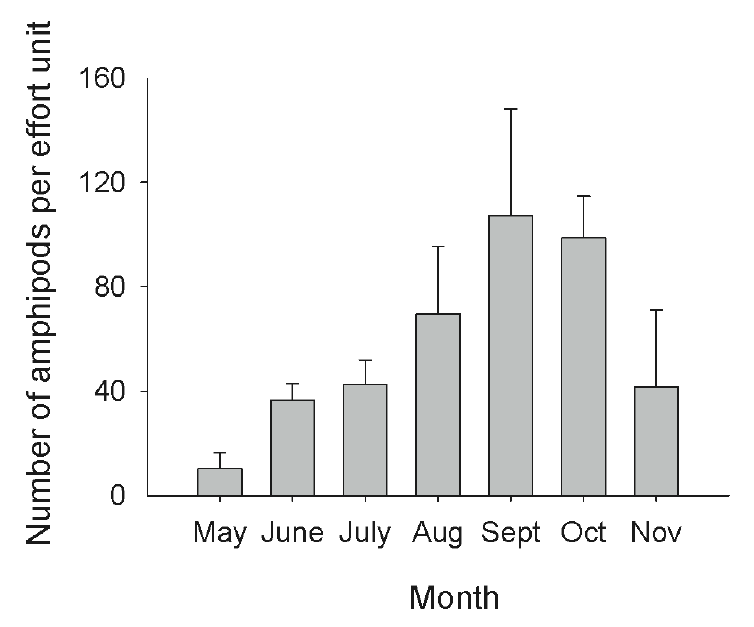
Figure 3. Monthly total abundance of amphipods sampled at site 1 in 2007 (mean ± standard